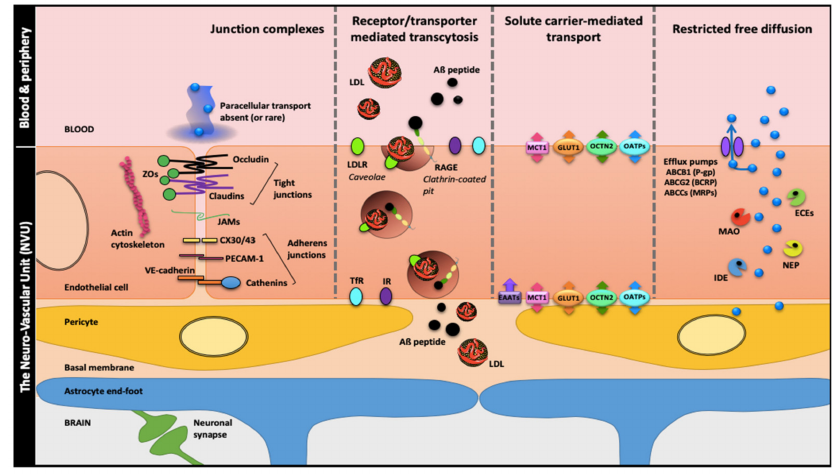
Figure 1. The blood-brain barrier (BBB), a solid wall within the brain microvasculature. Brain microvessels endothelial cells (ECs) are the bricks supporting the BBB phenotype with two main components: (i) a physical barrier which restricts transcytosis and seals the paracellular spaces between ECs through apical tight junctions (claudins, tricellulin and occludin linked to actin cytoskeleton by zonula occludens proteins), median junctional adhesion molecules (JAMs) and medio-basolateral Ca 2 + -dependent adherens junctions; (ii) a metabolic barrier supported by enzymes and e ffl ux pumps restricting nonspecific transport and favor receptor or transporter-specific routes. These features which cement the BBB ‘wall’ are induced, organized and maintained by cell–cell communications between the ECs and the close neighboring cells: brain pericytes, astrocytes (through their end-feet surrounding the brain microvessels) and neurons. These four cell types together with the basal membrane form the neurovascular unit (NVU). Abbreviations: ABCB1: ATP-Binding Cassette sub-family B